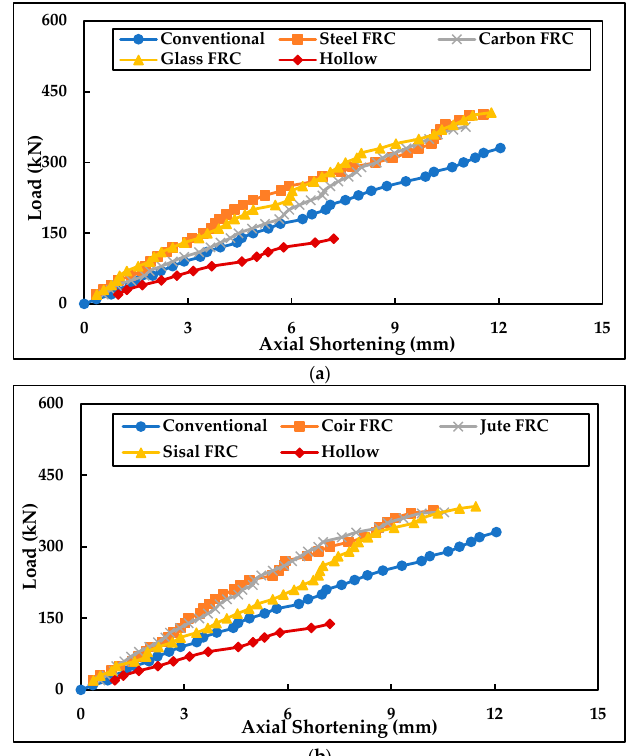
Figure 12. Graphical illustration of load vs. axial shortening of short column. ( a ) Artificial FRC. ( b ) Natural FRC.